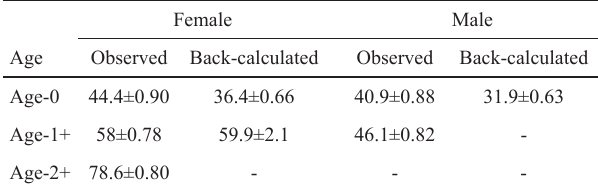
Fig. 2 . Relationships between male and female body weights, embryo counts, ovary weights and total length of Heterandria bimaculata in Cusuco National Park, Honduras in summer Table 1. Observed and back-calculated lengths at ages (± standard error) for Heterandria bimaculata in Cusuco National Park, Cortes Dept., Honduras.